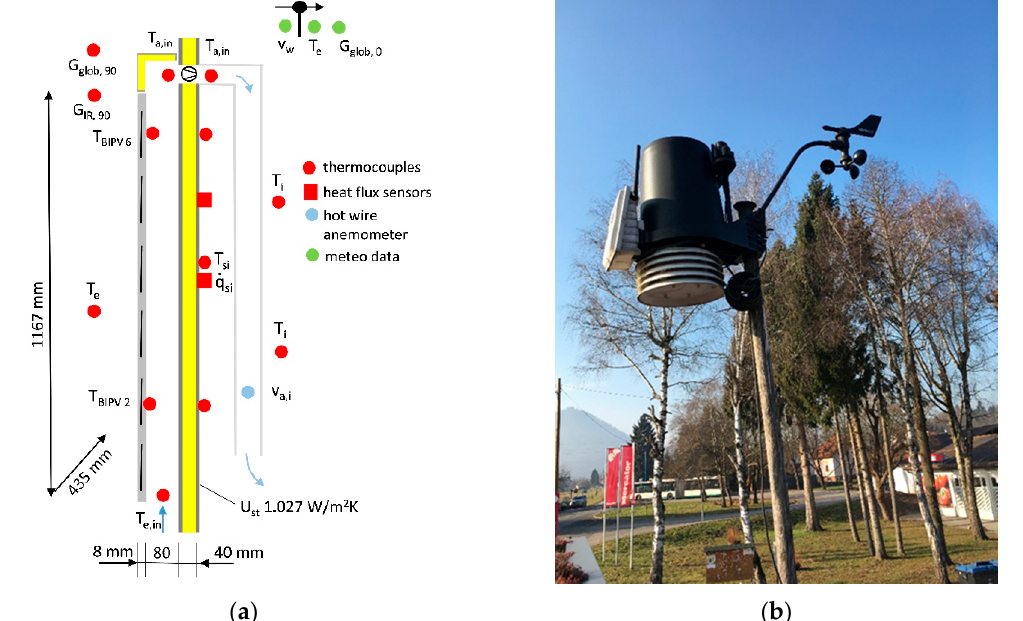
Figure 2. Position of sensors ( a ) and meteorological station Vantage Pro 2 ( b ).